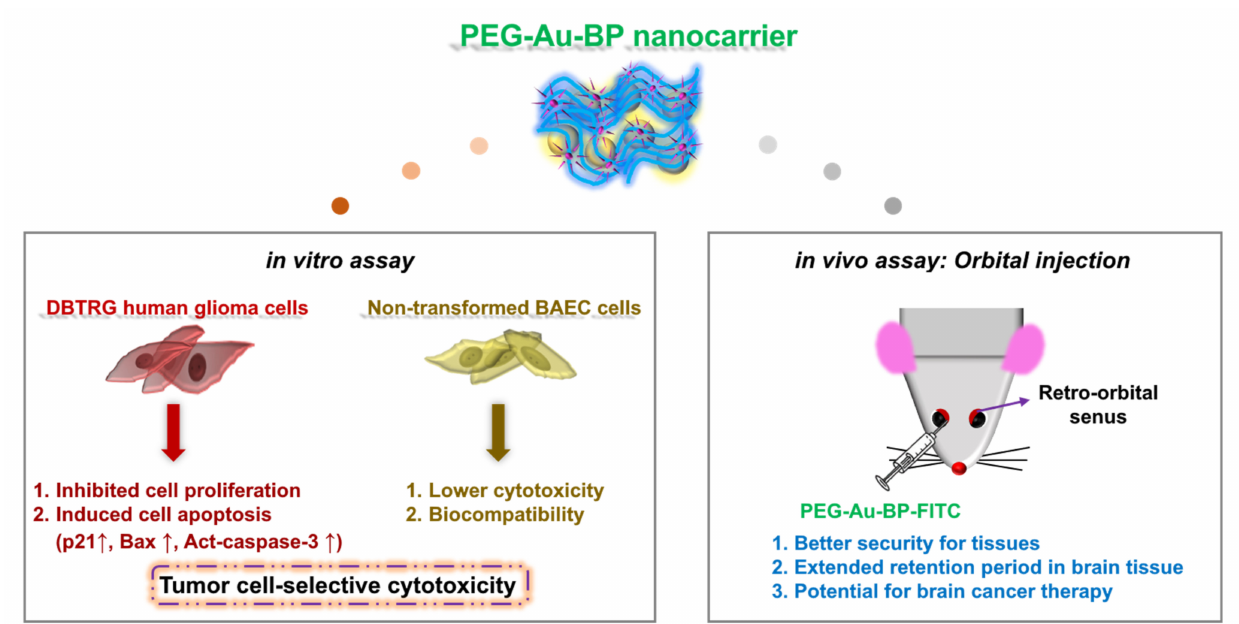
Figure 10. Schematic illustration for PEG-Au-BP nanocarrier through in vivo and in vitro assessments. The as-prepared PEG-Au-BP nanoparticles were applied to treat DBTRG human glioma cells and non-transformed BAEC cells. Based on the in vitro results, PEG-Au-BP could remarkably inhibit the proliferation of DBTRG brain cancer cells, as well as induce cell apoptosis. Furthermore, the evidence from in vivo assay strongly suggested PEG-Au-BP to be a bio-safety nanodrug for brain cancer